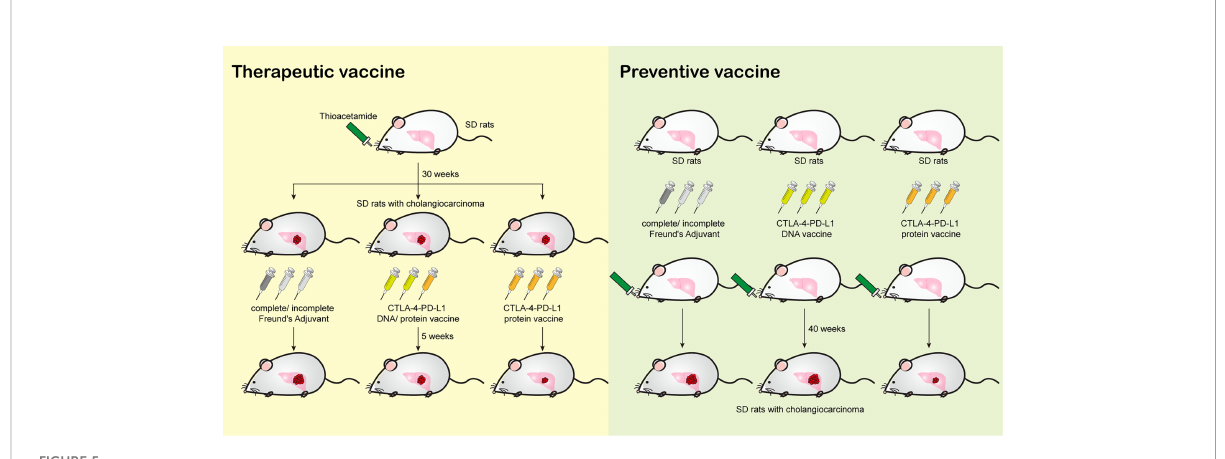
FIGURE 5 A diagram summarizing the major fi ndings in this